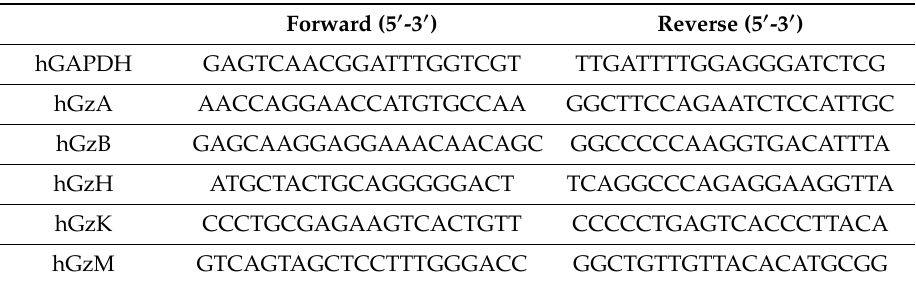
Table 1. Primers for indicated